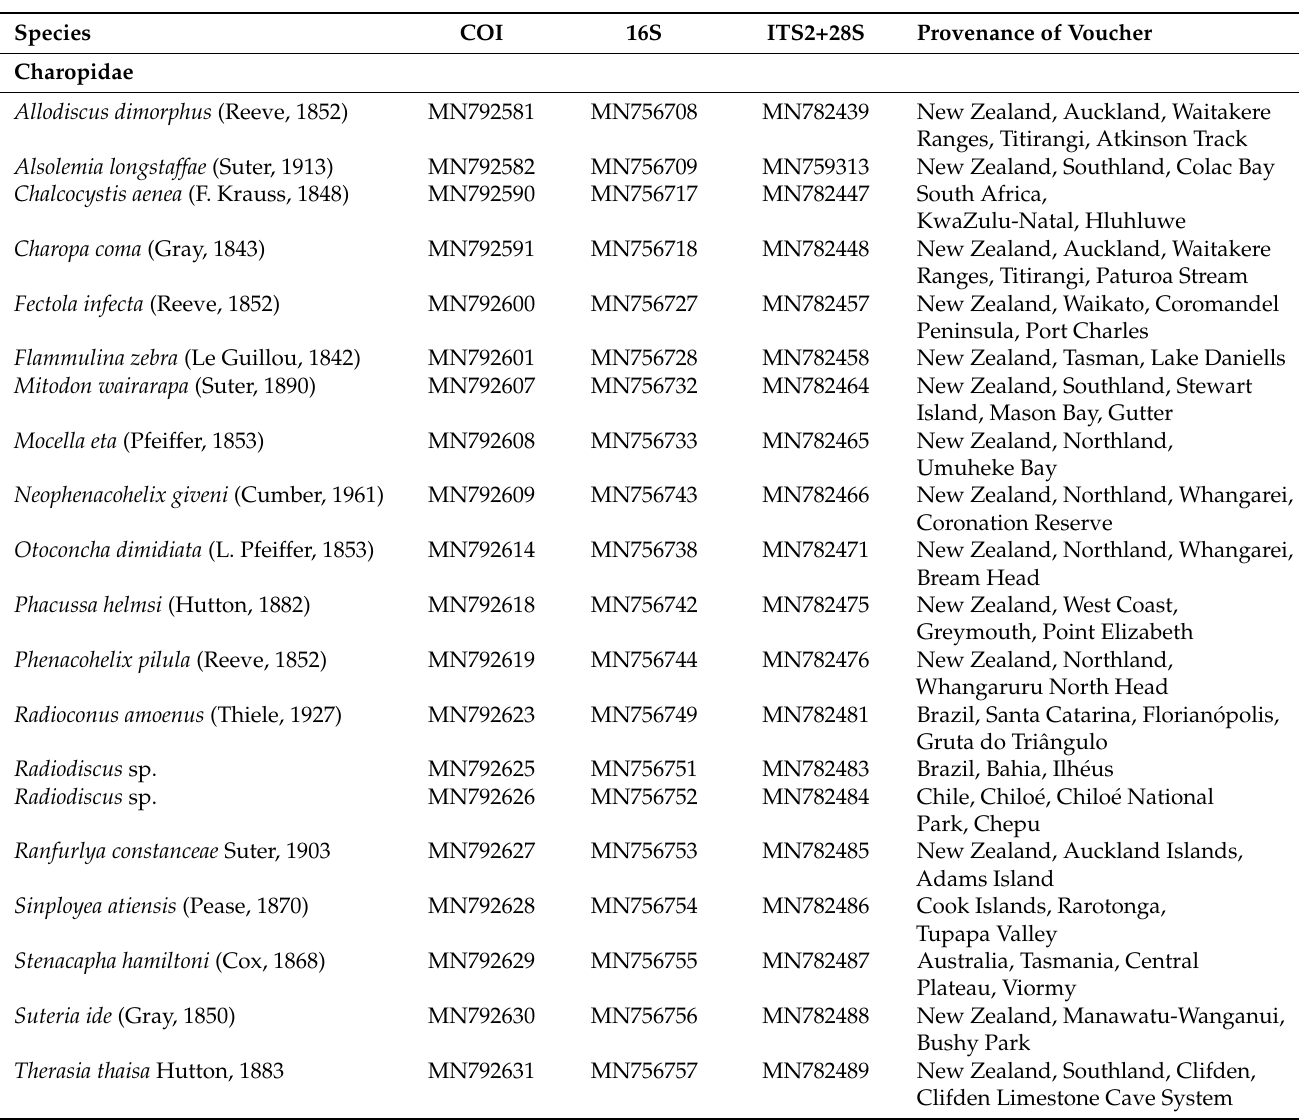
Table 2. List of species used in the phylogenetic analysis for which data were retrieved from GenBank, with accession numbers for each marker, and provenance data of the voucher